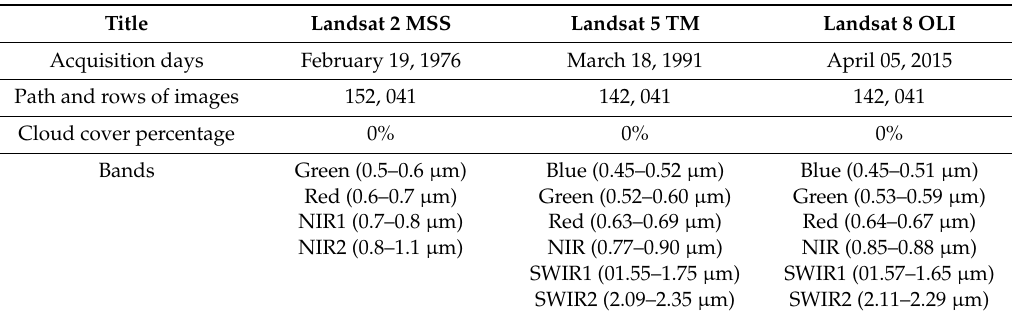
Table 1. Surface reflectance bands of Landsat 2 (Multispectral Scanner), 5 (Thematic Mapper), and 8 (Operational Land Imager) used in this study. NIR and SWIR represent near-infrared band and short-wave infrared band, respectively.